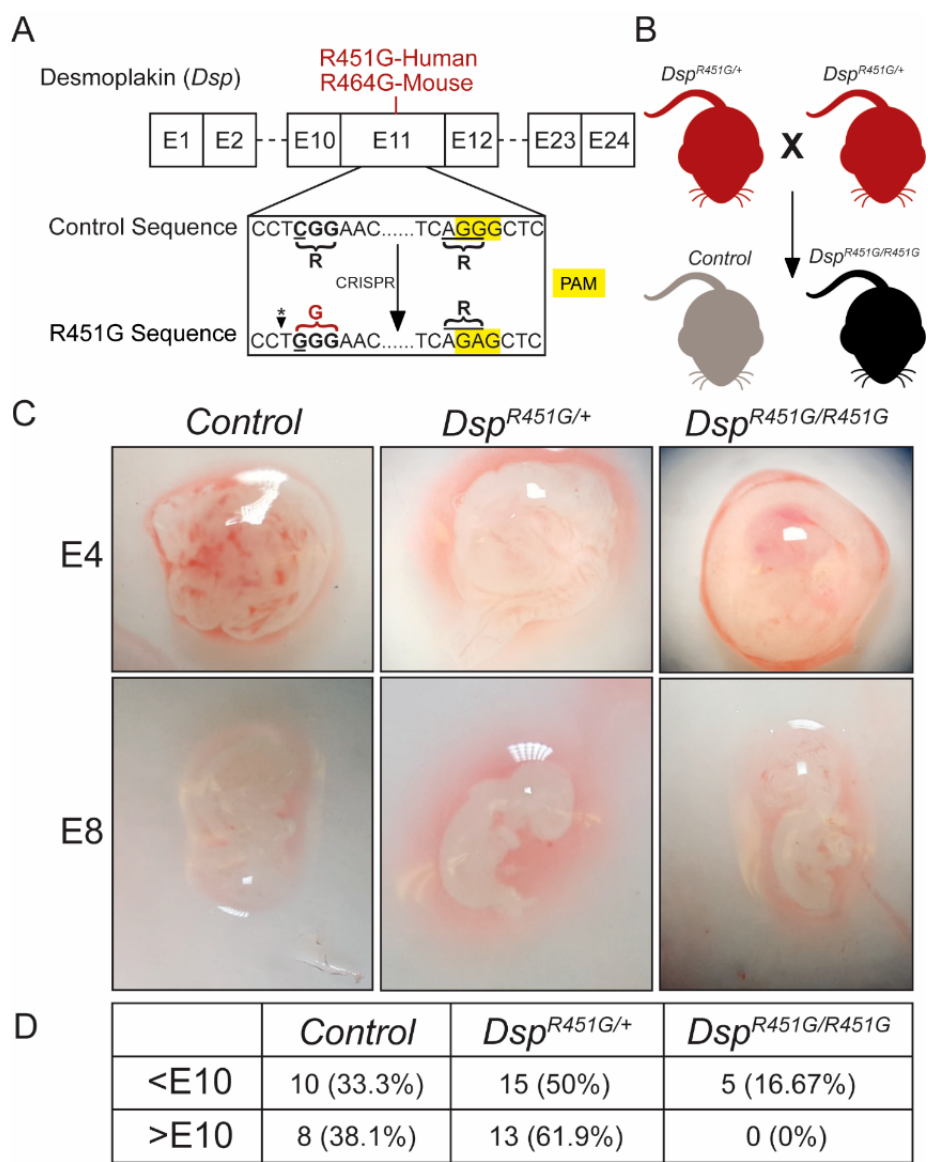
Figure 1. Schematic overview of the R451G mouse model. ( A ) Amino acid substitution occurs at residue R464, the murine equivalent of the human R451G variant. Alteration at the PAM site results in no changes within the coding sequences. * Introduction of the R451G variant results in the generation of a restriction enzyme cut site for BstNI (CC ∨ WGG) that was utilized for genotyping. ( B ) Schematic for the generation of Dsp R451G/R451G mice and control littermates after backcrossing is completed. ( C ) Embryonic isolations at time points <E10 identified viable Dsp R451G/R451G embryos. ( D ) Breakdown of timepoints and genotypes from isolated embryos from Dsp R451G/+ X Dsp R451G/+ , with no viable Dsp R451G/R451G embryos isolated after E10.